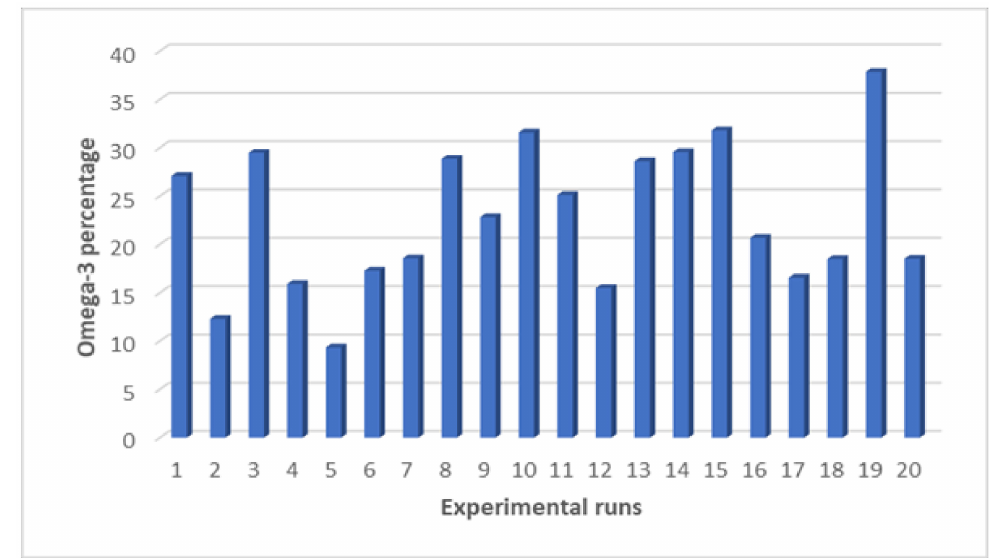
Figure 8. The distribution analysis for the experimental design including omega-3 percentage obtained from Nannochloropsis sp . microalgae via MAE technique with 10% ( w / v ) brine as the extraction solvent.